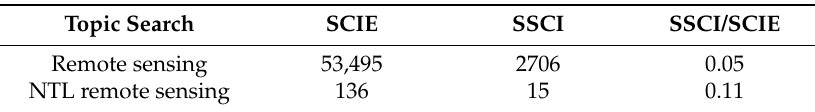
Table 9. Amount and proportion of publications in SCIE and SSCI of Remote Sensing and NTL Remote Sensing.